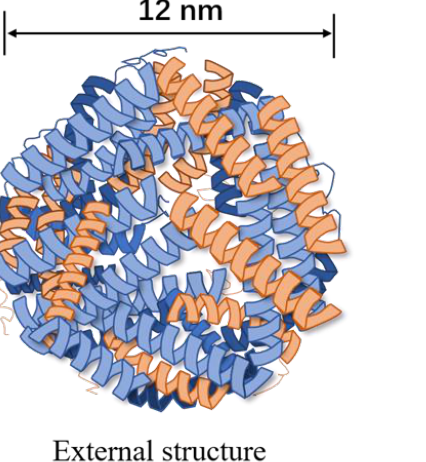
Figure 1. External and internal structure of ferritin.